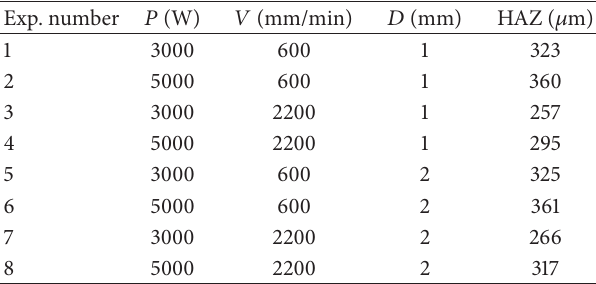
Table 4: Design matrix and experimentally measured response